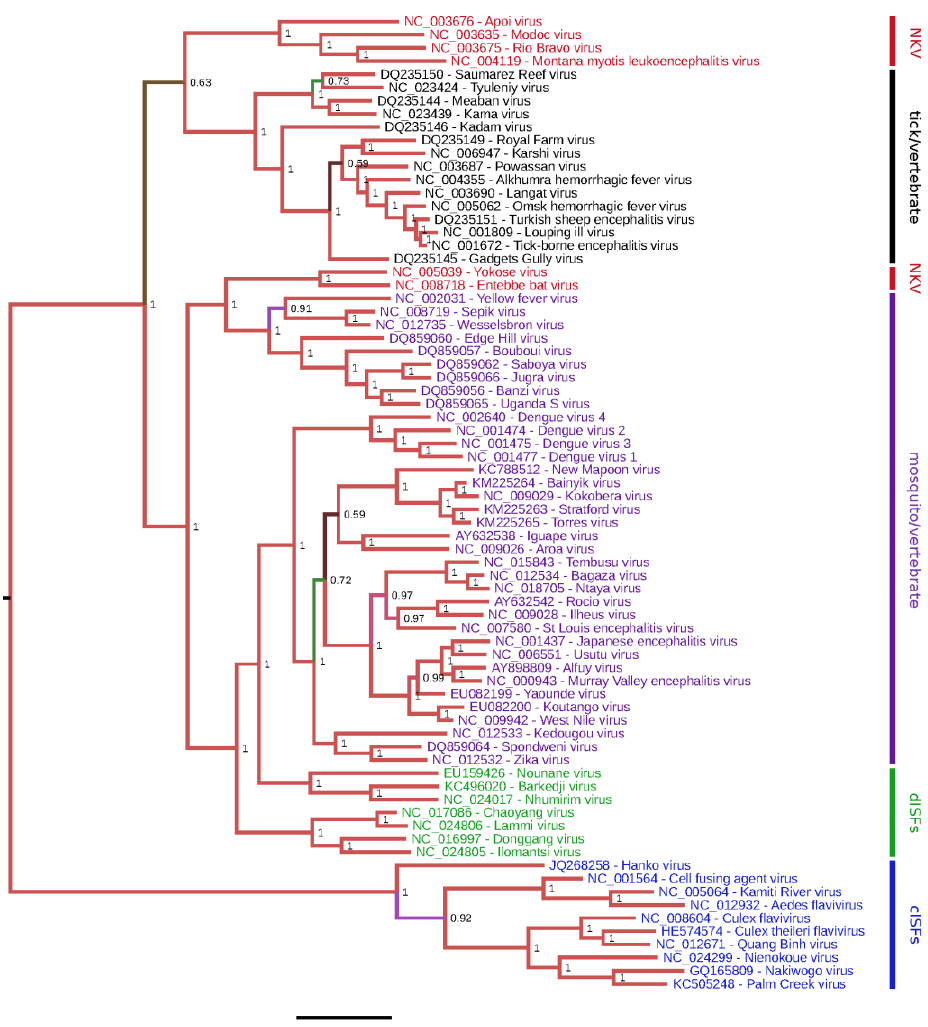
Figure 1. Phylogenetic tree for genus Flavivirus . Complete polyprotein amino acid sequences were aligned using MUSCLE [14]. Regions of ambiguous alignment were excised using Gblocks [15] with default parameters, after which 1774 amino acid positions were retained. A maximum likelihood phylogenetic tree was estimated using the Bayesian Markov chain Monte Carlo method implemented in MrBayes version 3.2.3 [16] sampling across the default set of fixed amino acid rate matrices, with 10 million generations, discarding the first 25% as burn-in. The figure was produced using FigTree (http://tree.bio.ed.ac.uk/ software/figtree/). The tree is midpoint-rooted, nodes are labelled with posterior probability values, and branches are also highlighted with alternative colors. Species names are color- coded as follows: cISFs—blue; dISFs—green; NKV flaviviruses—red; mosquito/vertebrate flaviviruses—purple; tick/vertebrate